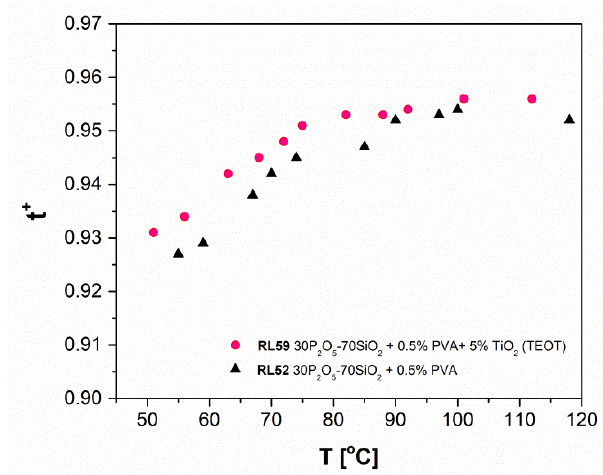
Figure 4. The variation in transference number t ion of samples RL52 and RL59 determined by means of electromotive force (EMF) measurements of a hydrogen concentration cell.